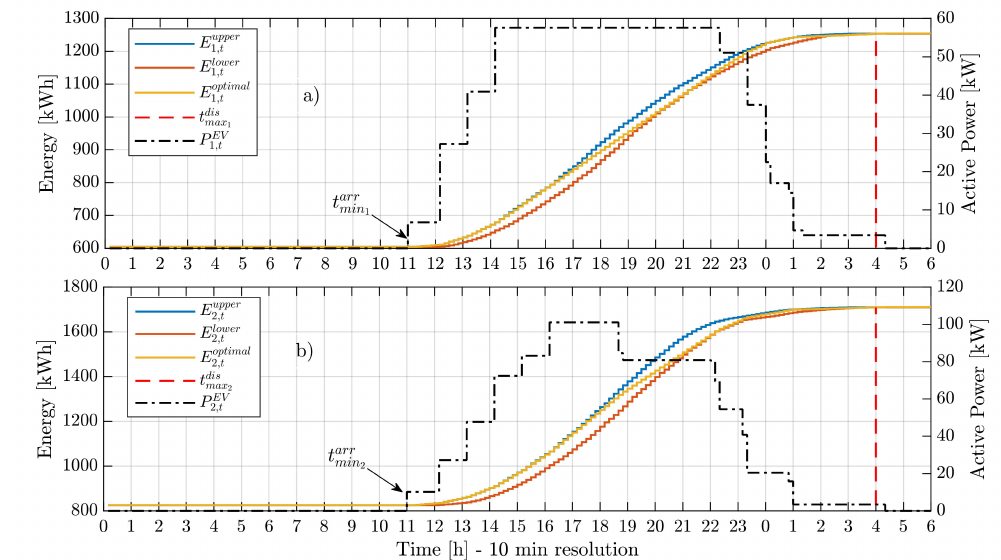
Figure 4. Optimal charging trajectory and charging profile for a critical penetration level: ( a ) aggregator 1 and ( b ) aggregator